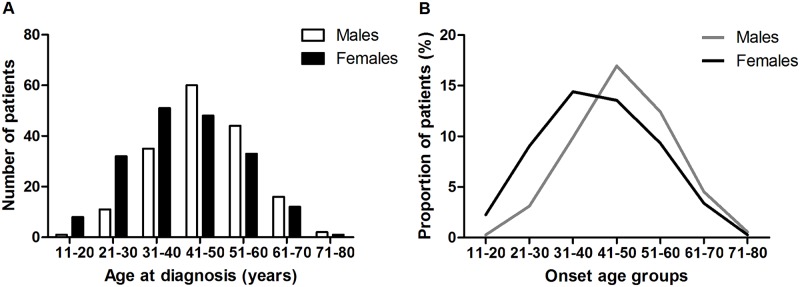
The age at diagnosis of patients with TAO.(A) The bar diagram and (B) linear curves demonstrate the age at diagnosis (years) of patients with TAO.